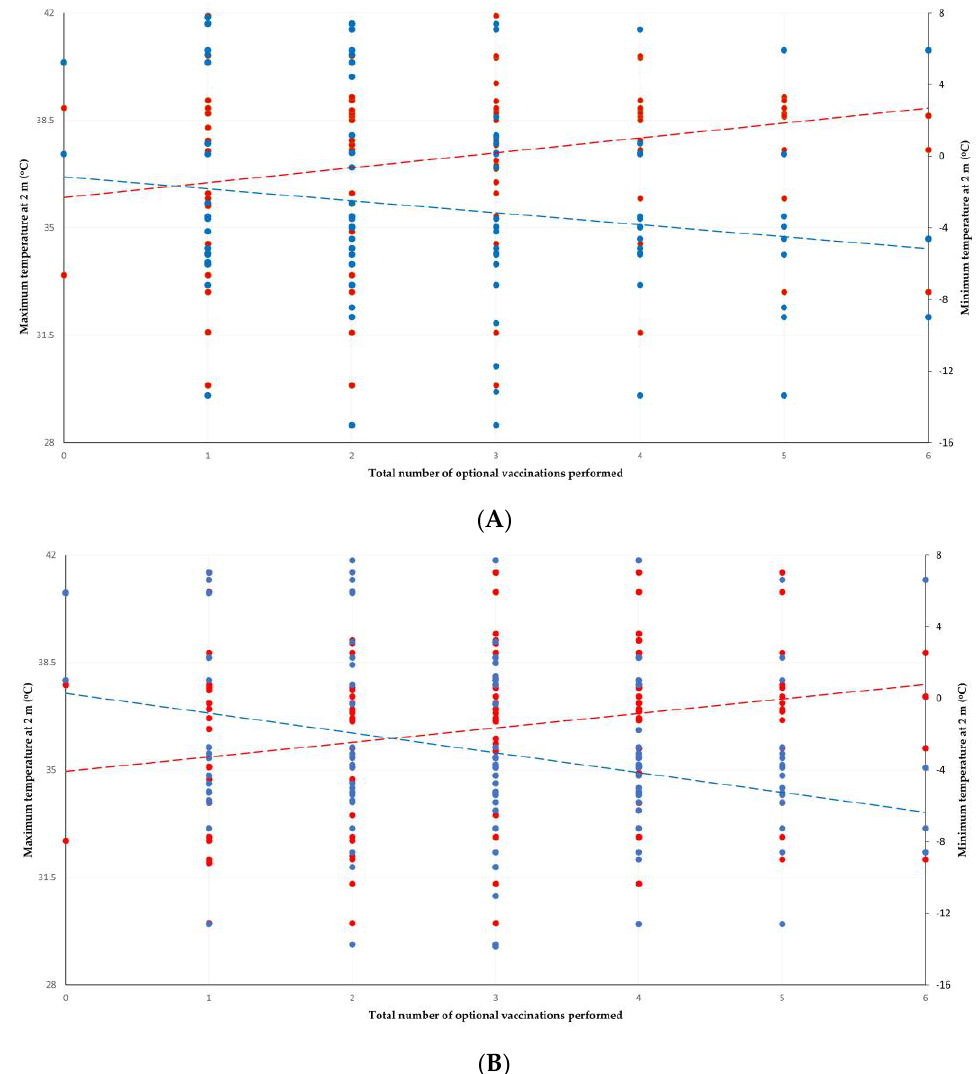
Figure 2. Scatter plots of the total number of optional vaccinations versus the maximum temperature at 2 m (red dots) and the minimum temperature at 2 m (blue dots) in small ruminant farms in Greece in which semi-extensive or extensive management is applied (dotted lines are respective trendlines): ( A ) the 10-year dataset with the most significant variable at the maximum temperature at 2 m ( p = 0.0004), and ( B ) the 2-year dataset with the most significant variable at the minimum temperature at 2 m ( p = 0.0002) (Table S29).